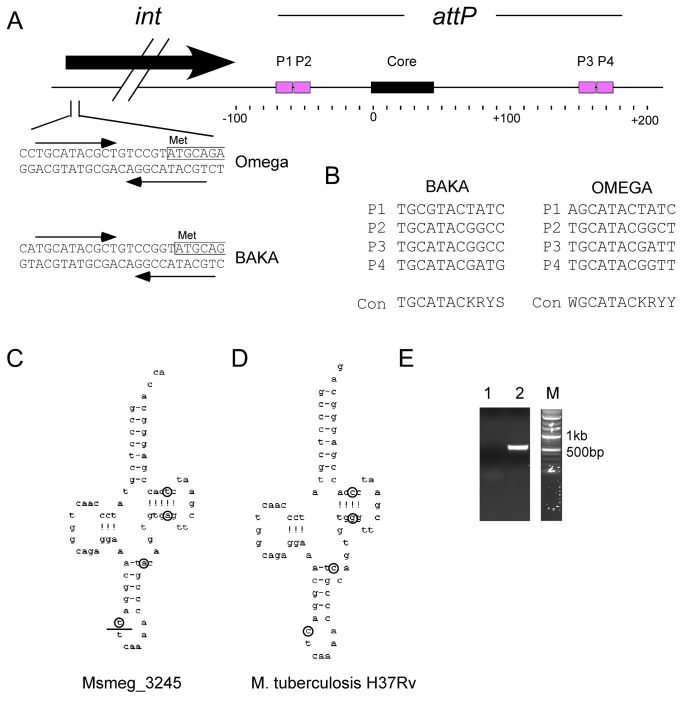
Integration functions of Cluster J phages.
A. Architecture of the integration cassette in Cluster J phages. The attP site is located downstream of the integrase gene with the 44 bp common core – which is shared by the attB site – located approximately 100bp from the 3’ end of int. The common core is flanked by pairs of putative arm-type integrase binding sites, P1 and P2 to its left, and P3 and P4 to its right. At the start of the int genes of Omega and BAKA there two arm-type-like binding sites in inverted orientation overlapping the putative integrase start codons. B. Sequences of the putative arm-type binding sites in BAKA and Omega, with the consensus sequences (con). C, D. Schematic representations of the tRNA-Leu genes overlapping the common core at attB in M. smegmatis (C) and M. tuberculosis (D). Sequence differences between the two tRNAs are circled. The left end of attB site is indicated by a horizontal line in the anticodon loop of the Msmeg_3245 tRNA. E. Agarose gel of PCR products demonstrating integration of plasmid pKR03. Lane 1 is a control using pKR03 DNA and primers deigned to amplify attR. Lane 2 uses the same primers and DNA from a pKR03 transformant.